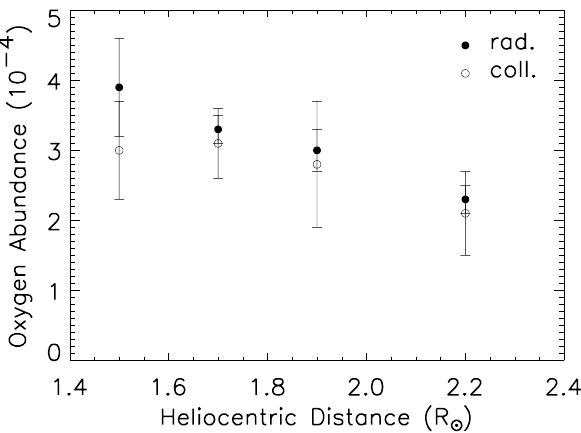
Fig. 6. Oxygen abundance relative to hydrogen as a function of heliodistance obtained by averaging the results from the 11 April and 5 June 1996 data. The streamer core and lateral structures are denoted with full and open triangles, respectively. The values are averages of the results obtained with the ratio of the radiative and collisional components.